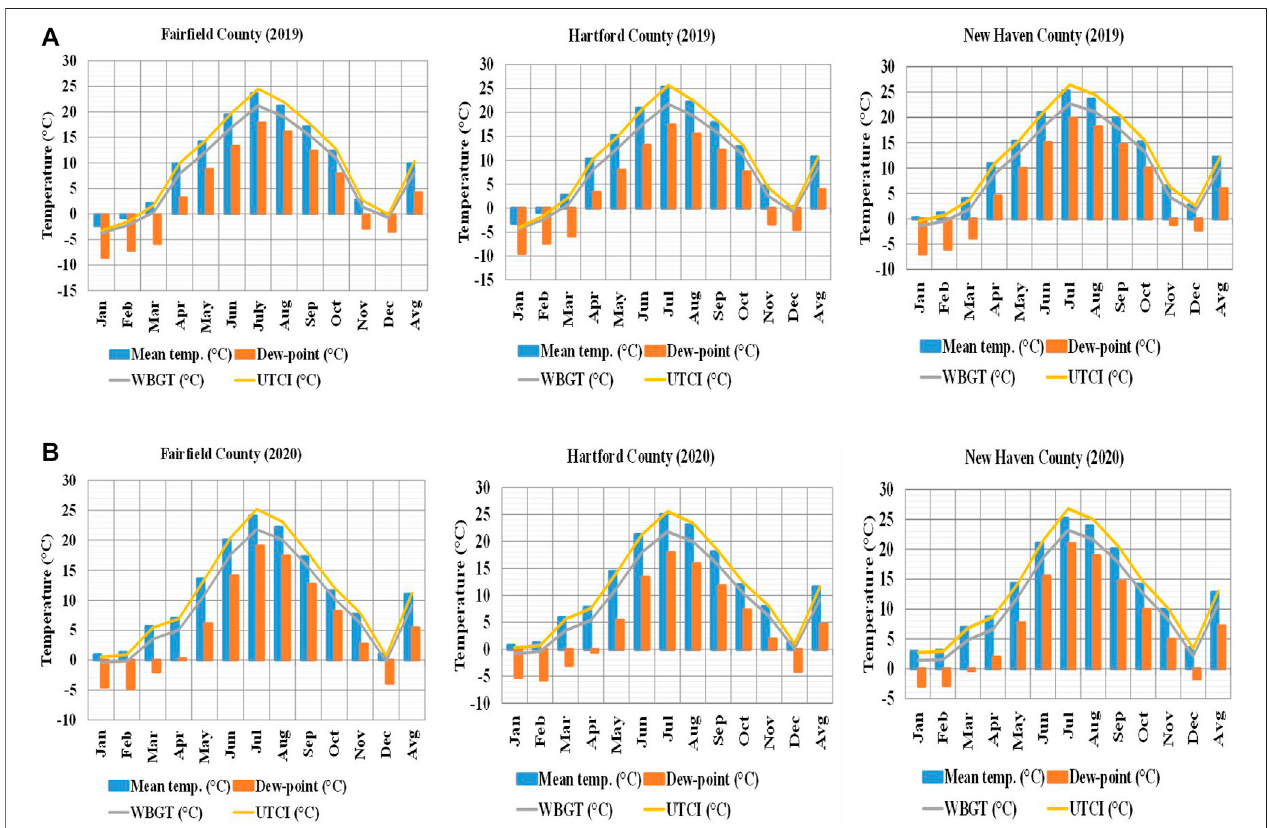
FIGURE 8 | (A) : Links between mean temperatures, dewpoint, and thermal indices in Fair fi eld (left) , Hartford (middle) , and New Haven (right) in 2019 (pre- pandemic year). (B) : Links between mean temperatures, dewpoint, and thermal indices in Fair fi eld (left) , Hartford (middle) , and New Haven (right) in 2020 (pandemic